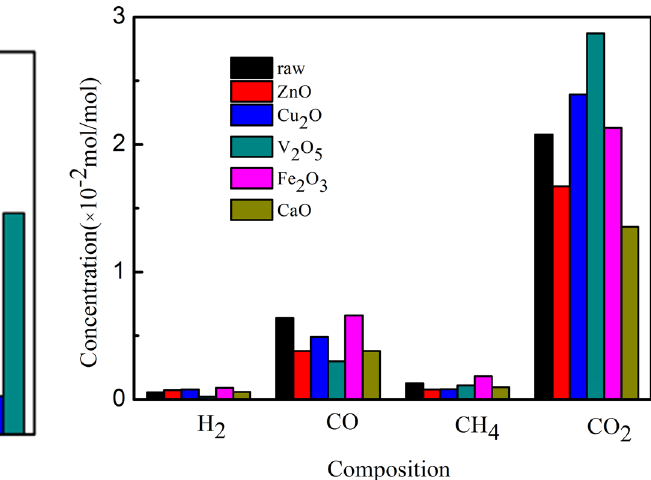
Figure 5: Gas distribution at di ff erent temperatures.